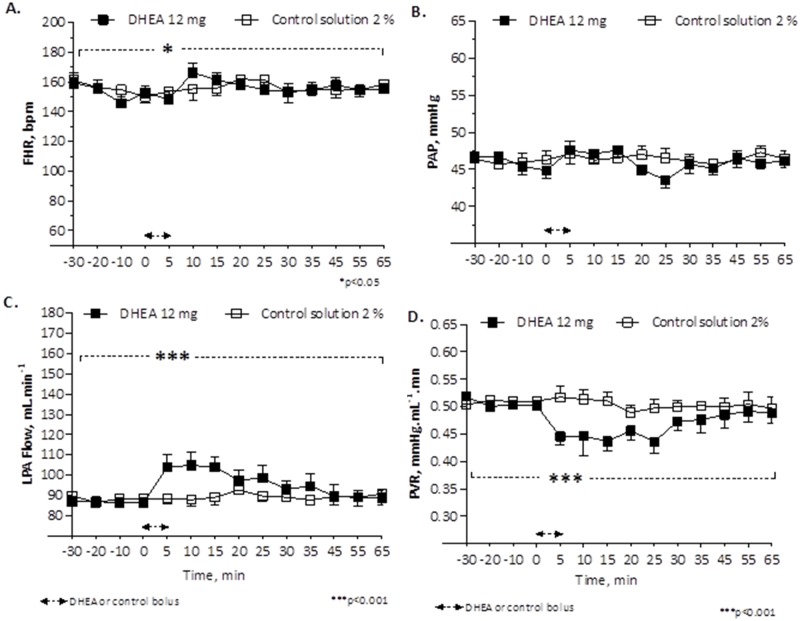
Change in fetal heart rate, FHR (A), pulmonary artery pressure, PAP (B), left pulmonary artery blood flow, LPA flow (C) and pulmonary vascular resistance, PVR (D) in response to bolus of 12 mg DHEA compared to bolus of control solution 2%.Values are means ±SEMs, n = 5, (DHEA 12 mg) and n = 5, (control 2%). *p<0.05 significant difference of FHR comparing baseline vs. 12 mg DHEA bolus and ***p<0.001 comparing baseline vs. 12 mg- DHEA bolus (one-way ANOVA) and comparing 12 mg- DHEA bolus vs. control 2% (Two-way ANOVA).